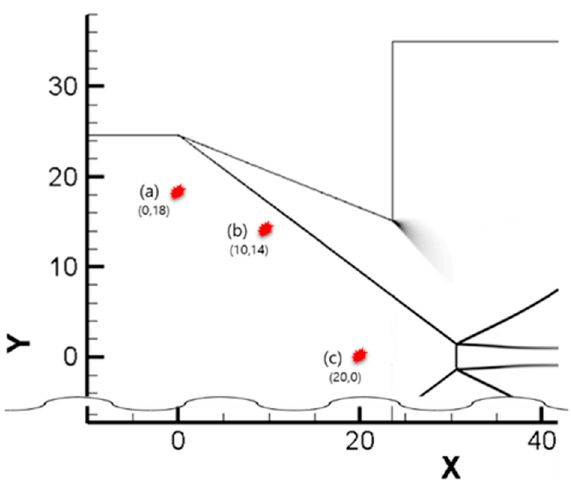
Figure 8. Location of energy deposition.